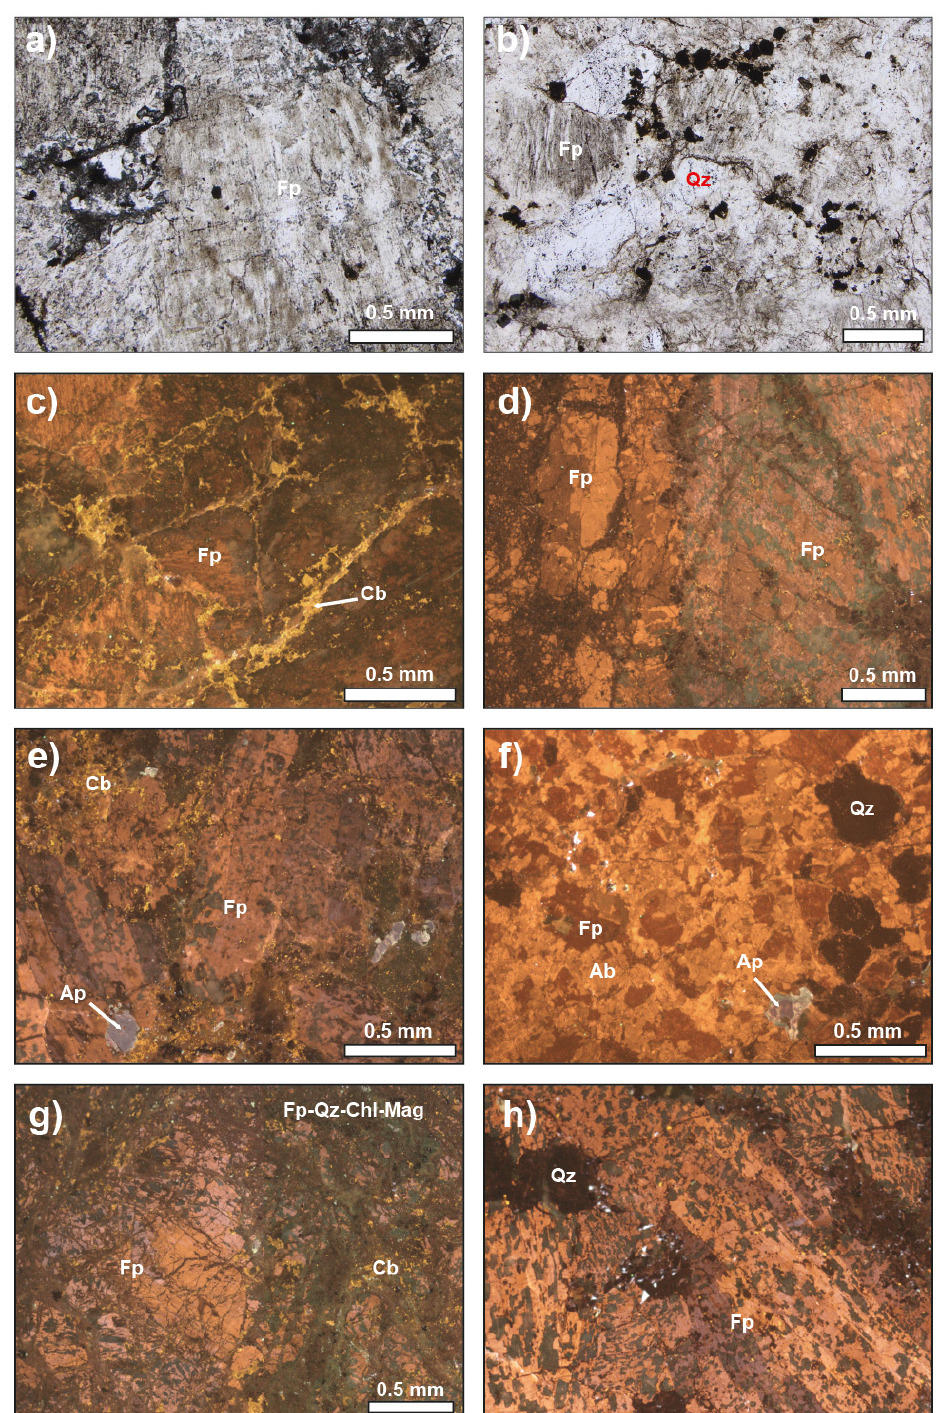
Figure 3. Douay samples D1A ( a ) and D3 ( b ) observed in transmitted light. Douay samples observed under cathodoluminescence and showing the distribution of alkali feldspar, quartz, carbonate, and apatite in samples D1A ( c , d ), D2 ( e ), D3 ( f ), D4 ( g ), and D5 ( h ). The abbreviations stand for albite (Ab), apatite (Ap), carbonate (Cb), chlorite (Chl), feldspar (Fp), magnetite (Mag), and quartz (Qz).